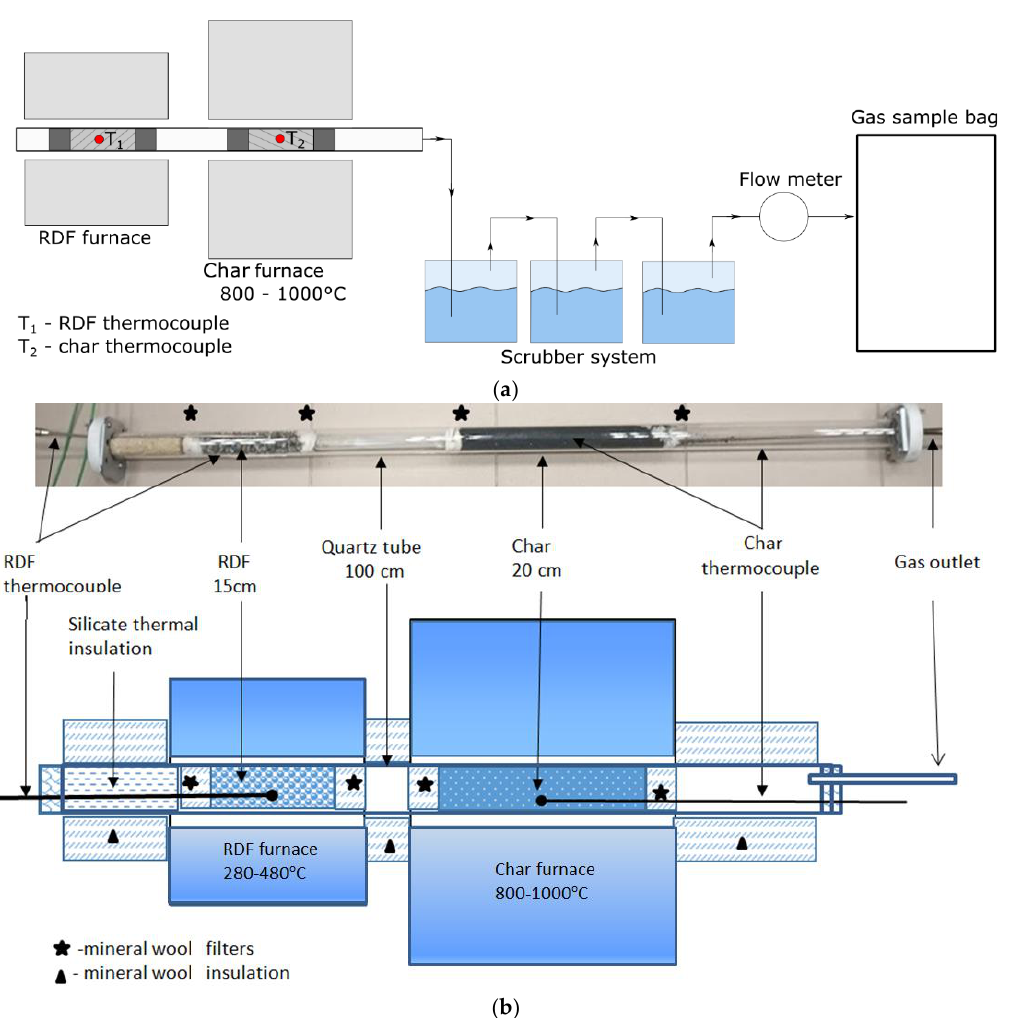
Figure 1. Experimental stand: ( a ) test-bed (schematic diagram); ( b ) two-furnace RDF pyrolysis setup; top photograph: chamber of the pyrolysis system; bottom schematic diagram: the pyrolysis system.